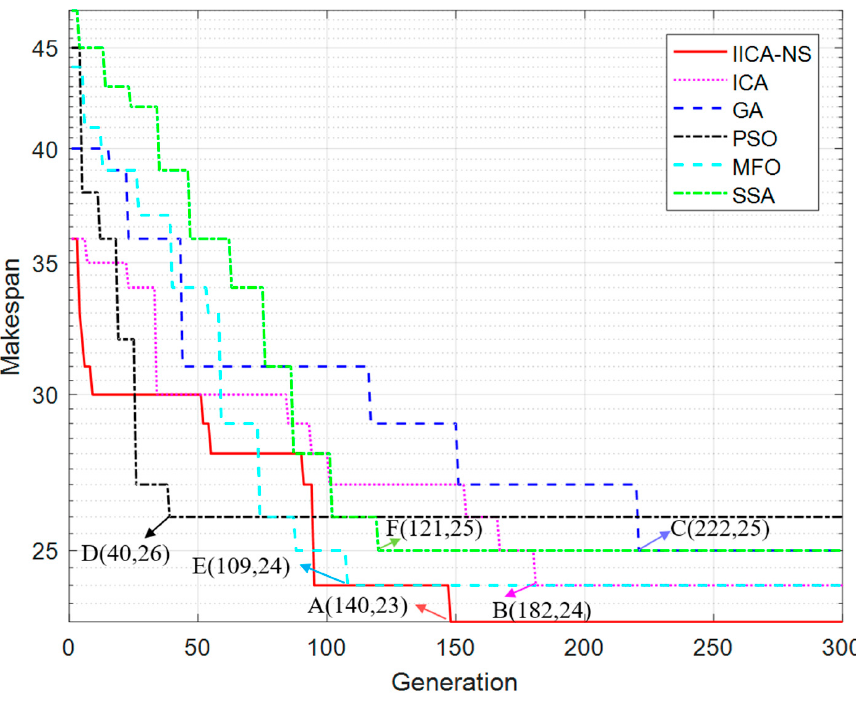
Figure 9. Comparison of six algorithms convergence curves for large-scale TPS8.